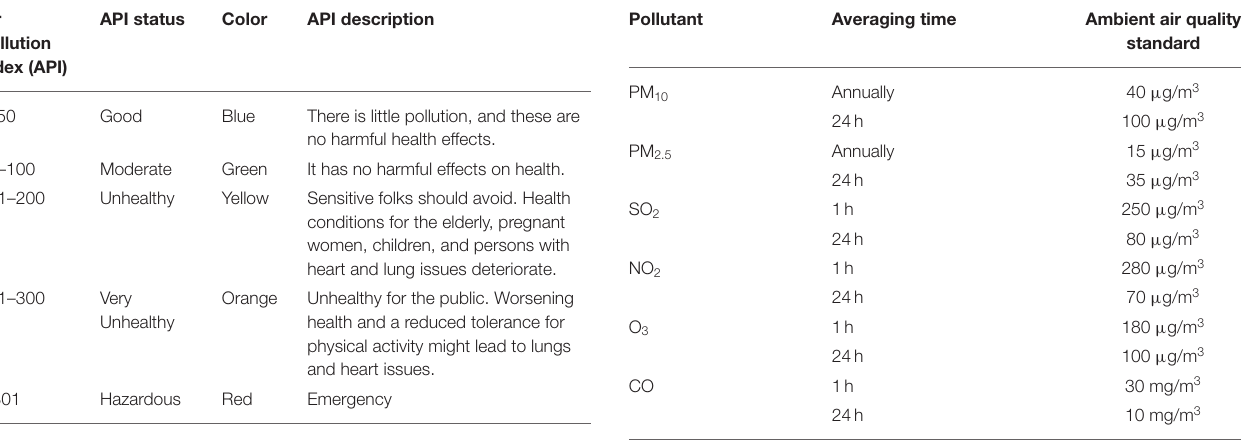
TABLE 8 | Air Pollution Index classification recommended by Department of Environment (DoE), Malaysia ( 37).